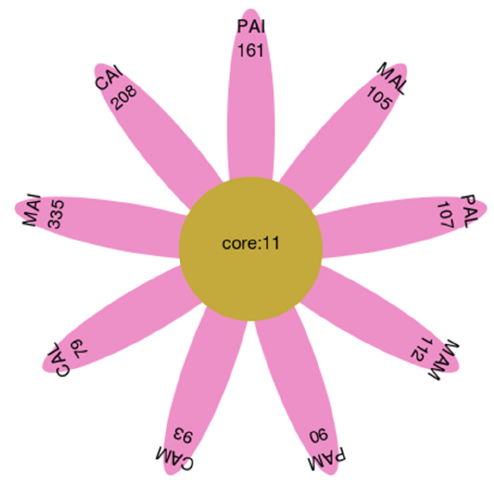
Figure 3. OTU distribution petal map. CAI is the pre-fermentation Cabernet Sauvignon, CAM is the mid-fermentation Cabernet Sauvignon, and CAL is the late fermentation Cabernet Sauvignon. MAI